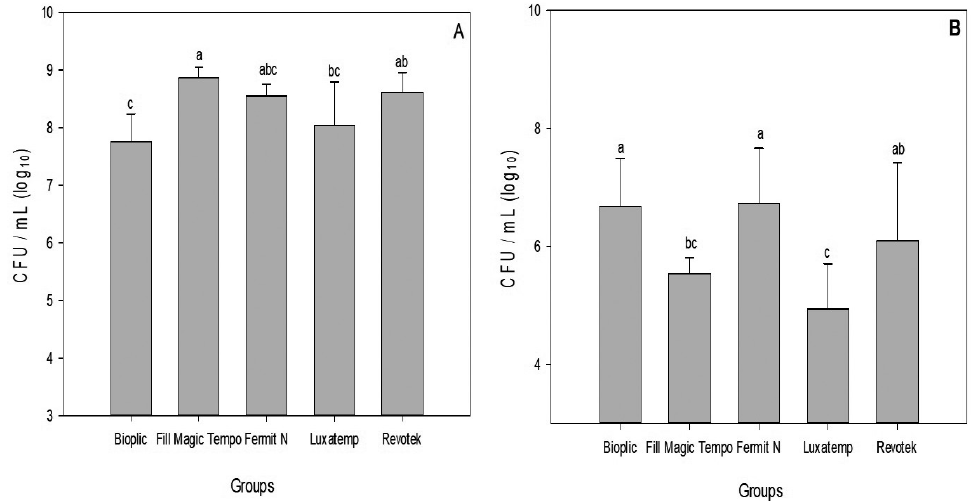
Figure 4- Survival de E. faecalis (ATCC4083) after direct contact with temporary filling materials; (A) temporary filling for 1 h. (B) temporary filling for 24 h. All materials were light-cured. Different letters represent statistically significant differences between groups (p<0.05)